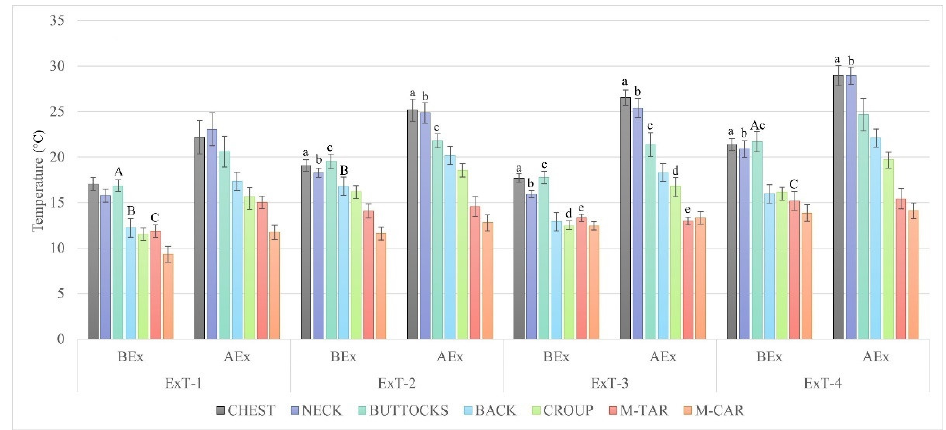
Figure 2. Body surface temperatures of different regions before and after exercise (BEx and AEx) in tests 1 to 4 (ExT-1 to ExT-4). M-TAR – metatarsus; M-CAR – metacarpus; a,b,c,d,e p < 0.001 within a test (before vs after exercise); A,B,C p < 0.001 between tests. The areas that warmed up the most after exercise in all four tests were the neck, fol- lowed by the chest, back, croup, and buttocks (Figure 3). The areas that warmed the least were the metacarpus and metatarsus; in ExT-3, the metacarpus actually cooled after exer- cise (Table 5). The differences in heating between regions were not significant between tests ( p > 0.05), with the exception of the metatarsus ( p < 0.05). In contrast, when comparing different regions within a single test, significant differences in heating were confirmed for ExT-2 ( p < 0.001), ExT-3, and ExT-4 ( p < 0.0001, respectively). Significant differences were also found in the heating of the warmest (neck, chest) and coldest regions (metacarpus, metatarsus; see Table 5). Table 5. Heating of the examined regions after exercise (differences between absolute body surface temperatures before and after exercise in tests 1 to 4 (ExT-1 to ExT-4)).